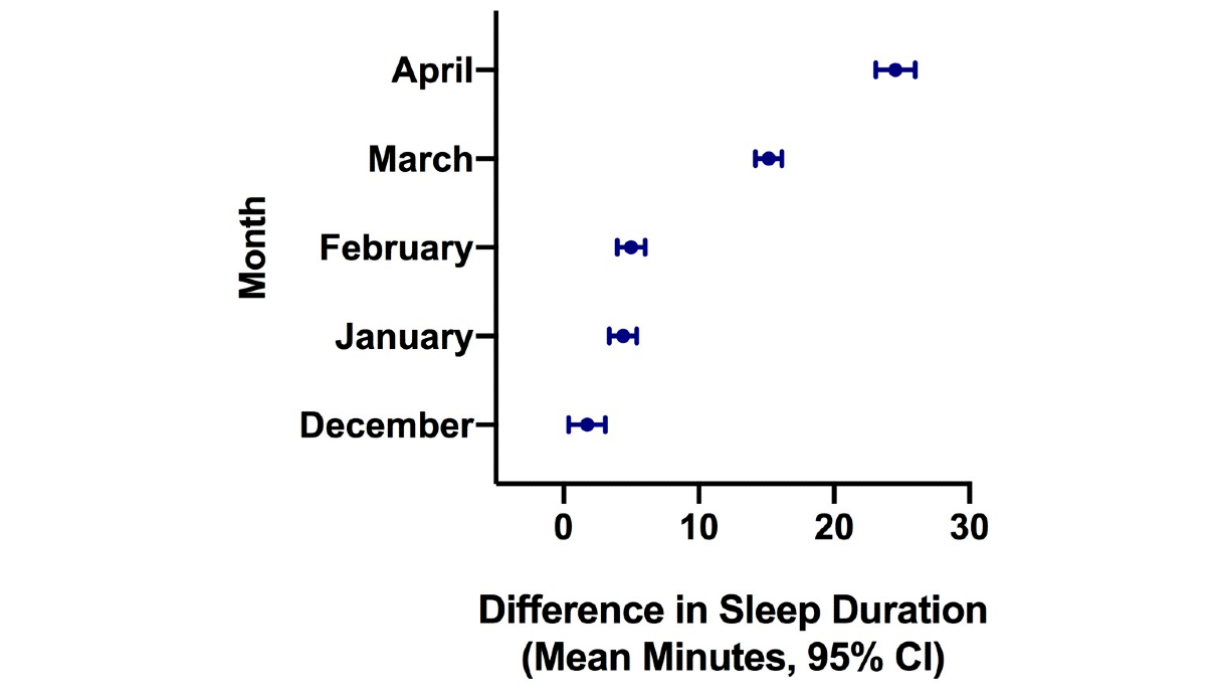
Figure 6. Difference in estimated sleep duration during the COVID-19 pandemic compared to the same month in the previous year in New York.